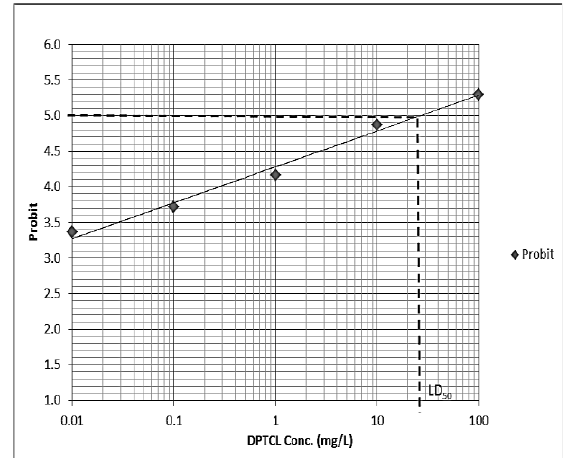
Figure 3: Acute toxicity of DPTCl on shrimps after 24 h exposure